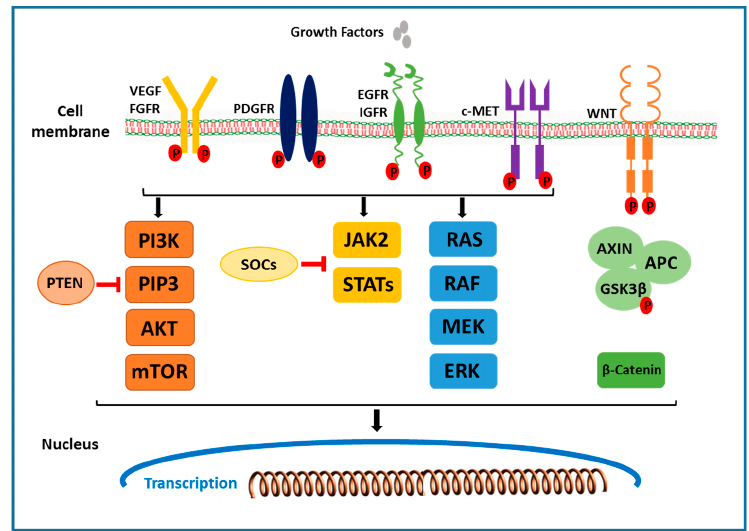
Figure 1. Schematic representation of major signaling pathways involved in hepatocellular carcinoma.